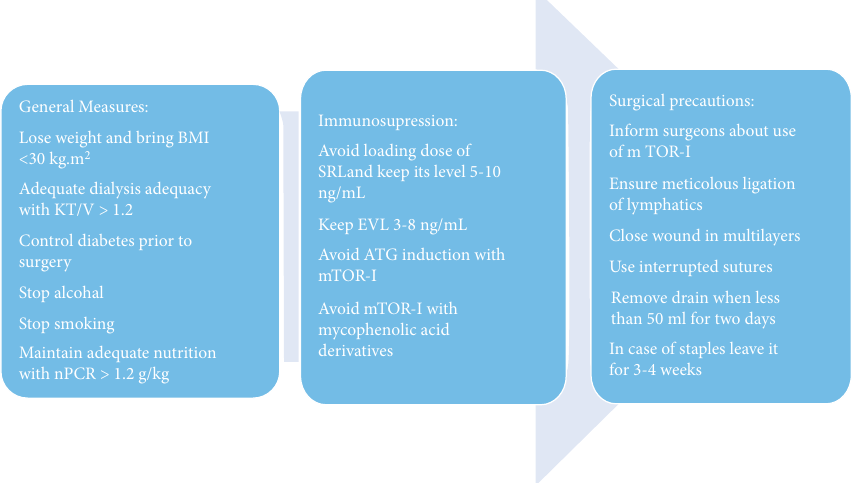
Figure 2: Showing the way forward to minimize wound healing. Table 4: Summaries of randomized control trial performed on